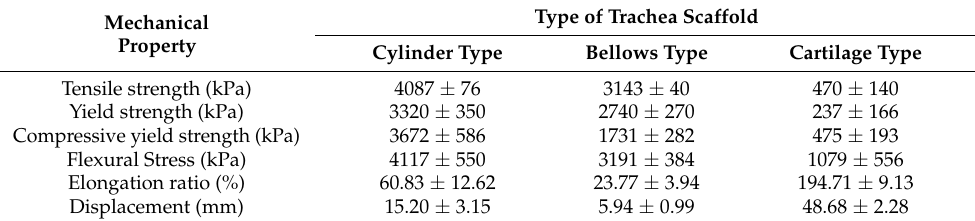
Table 1. Mechanical properties of various types of trachea